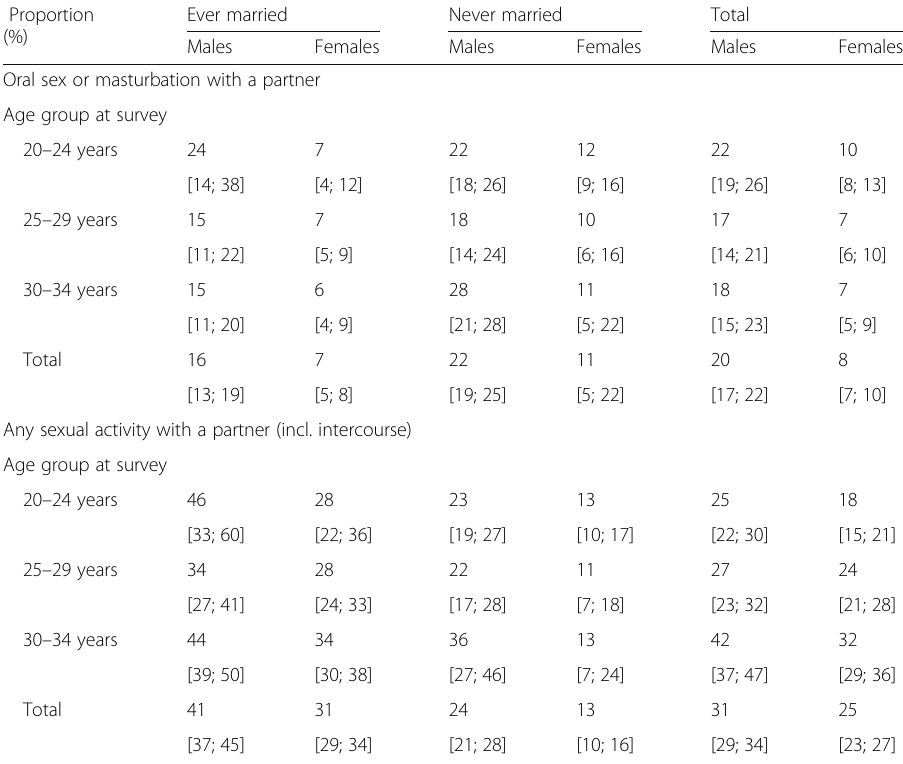
Table 3 Reported premarital sexual activities by sex and marital status Proportion Ever (%)